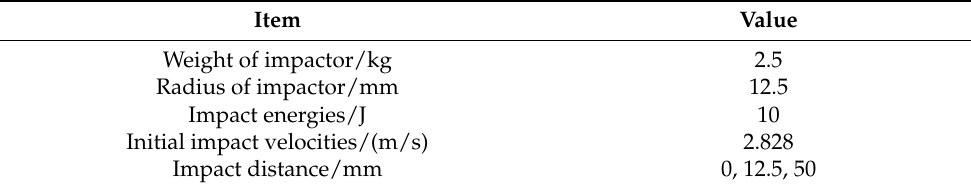
Table 1. Impact test parameters of patch-repaired double-impacts specimens.